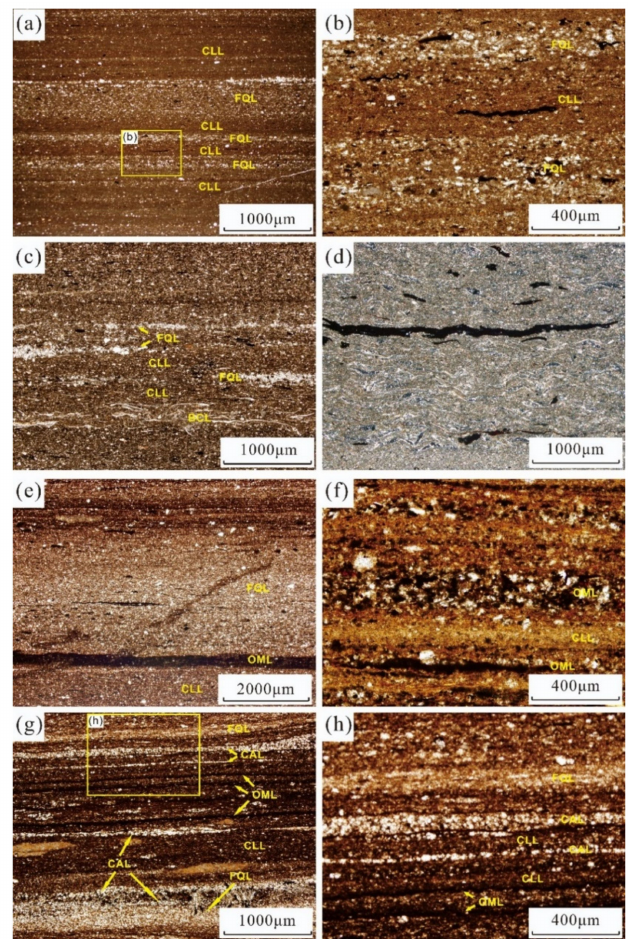
Figure 3. Optical microscope images of different laminae of the second Member of Kongdian Formation in the Cangdong Sag. ( a , b ) Combination of FQL and CLL, the CLL interbedded with the FQL, plane-polarized light; ( c ) combination of FQL, CLL, and BCL, the CLL interbedded with the FQL and the BCL, plane-polarized light; ( d ) BCL, straight or arc shape, cross-polarized light; ( e , f ) combination of FQL, CLL, and OML, plane-polarized-light; ( g , h ) combination of FQL, CAL, CLL, and OML, the CLL interbedded with the FQL, CAL, and OML, plane-polarized light. FQL: feldspar-quartz laminae; CLL: clay laminae; CAL: carbonate laminae; OML: organic matter laminae; BCL: bioclastic